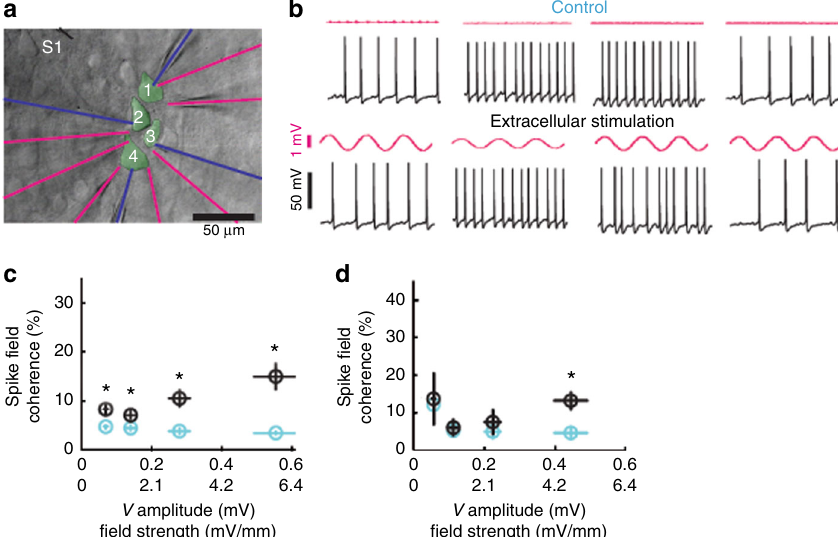
Fig. 3 Field-entrainment of spikes under idealized conditions in vitro. Synaptic transmission was blocked pharmacologically. a Four neurons with somata located within 100 μ m of tissue were patched with intracellular electrodes (blue). Seven extracellular electrodes monitored extracellular voltage ( V e) fl uctuations (magenta). An extracellular stimulation electrode (S1) was placed 50 – 80 μ m from the recorded somata. b Each of the four intracellularly recorded neurons were depolarized to induced spiking. Spiking in the absence (top traces) and in the presence of extracellular stimulation (magenta; 100 nA at 1 Hz; bottom traces) is shown. c Spike fi eld coherence (circles, mean; error bars, s.e.m.) between spikes and extracellular V e is shown during 1 Hz extracellular stimulation (black) and control condition (cyan; circles indicate mean V e amplitude at the soma and error bars indicate s.e.m.) as a function of stimulation strength. Asterisks indicate statistical signi fi cance of the spike- fi eld difference between control and extracellular stimulation. d Spike-spike coordination (spike- fi eld coherence for two simultaneously occurring spikes; essentially spike synchrony among neurons) during 1 Hz extracellular stimulation (black) and control (cyan) condition. Note that stronger fi elds are needed for coherent entrainment of neuronal spikes across the four neurons ( d ) than for inducing spike- fi eld coherence for each neuron separately ( c ). Figure reproduced with permission